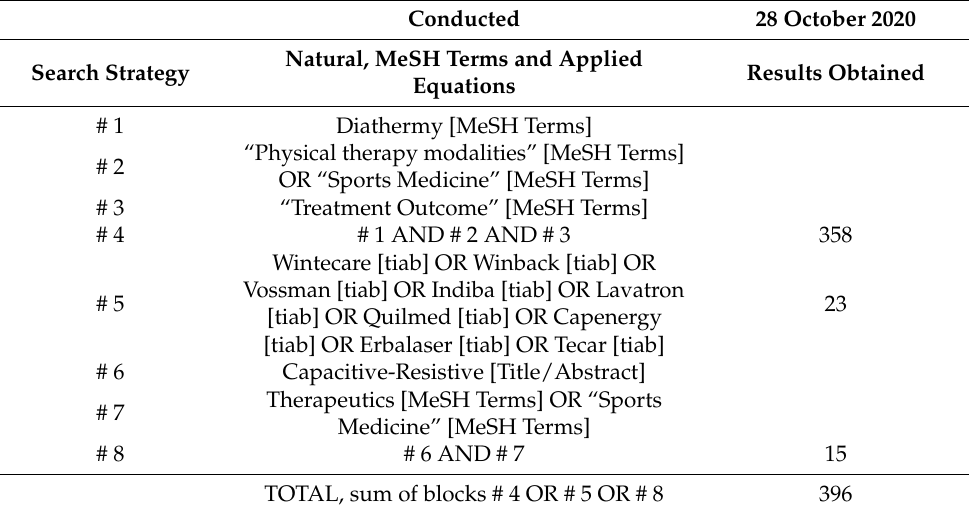
Table 1. This table shows the combination of thesaurus and natural terms used on the PUBMED search string and with its corresponding